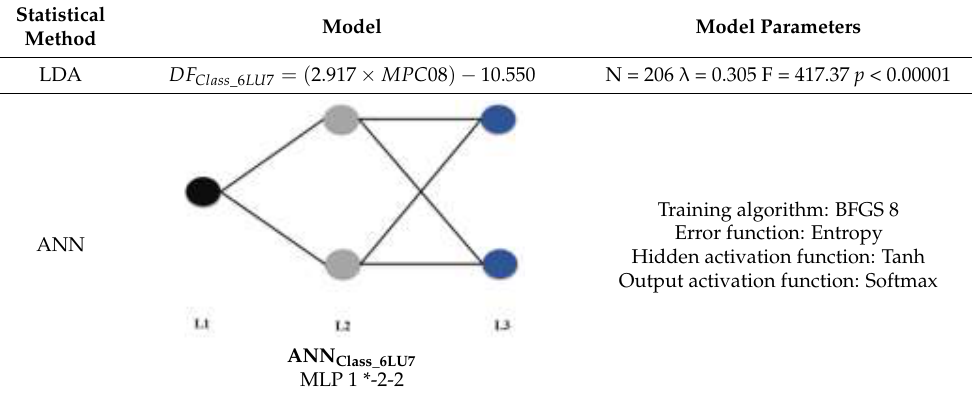
Training algorithm: BFGS 8 Error function: